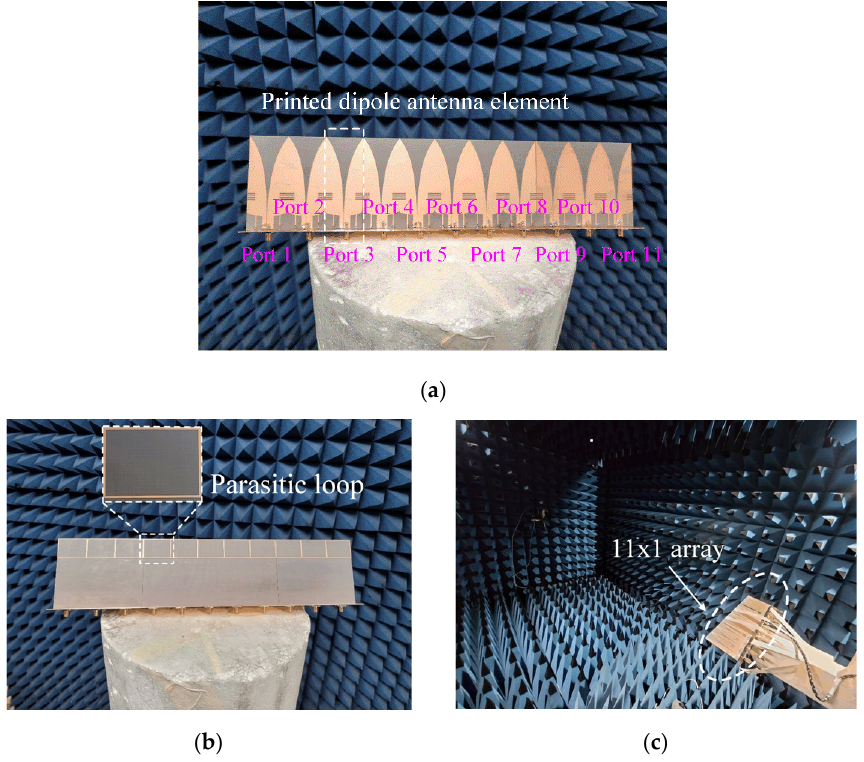
Figure 7. Photographs of the fabricated 11 × 1 uniform linear array antenna and measurement setup: ( a ) front view; ( b ) back view; ( c ) measurement setup. Table 2. Values of the optimized array antenna element.